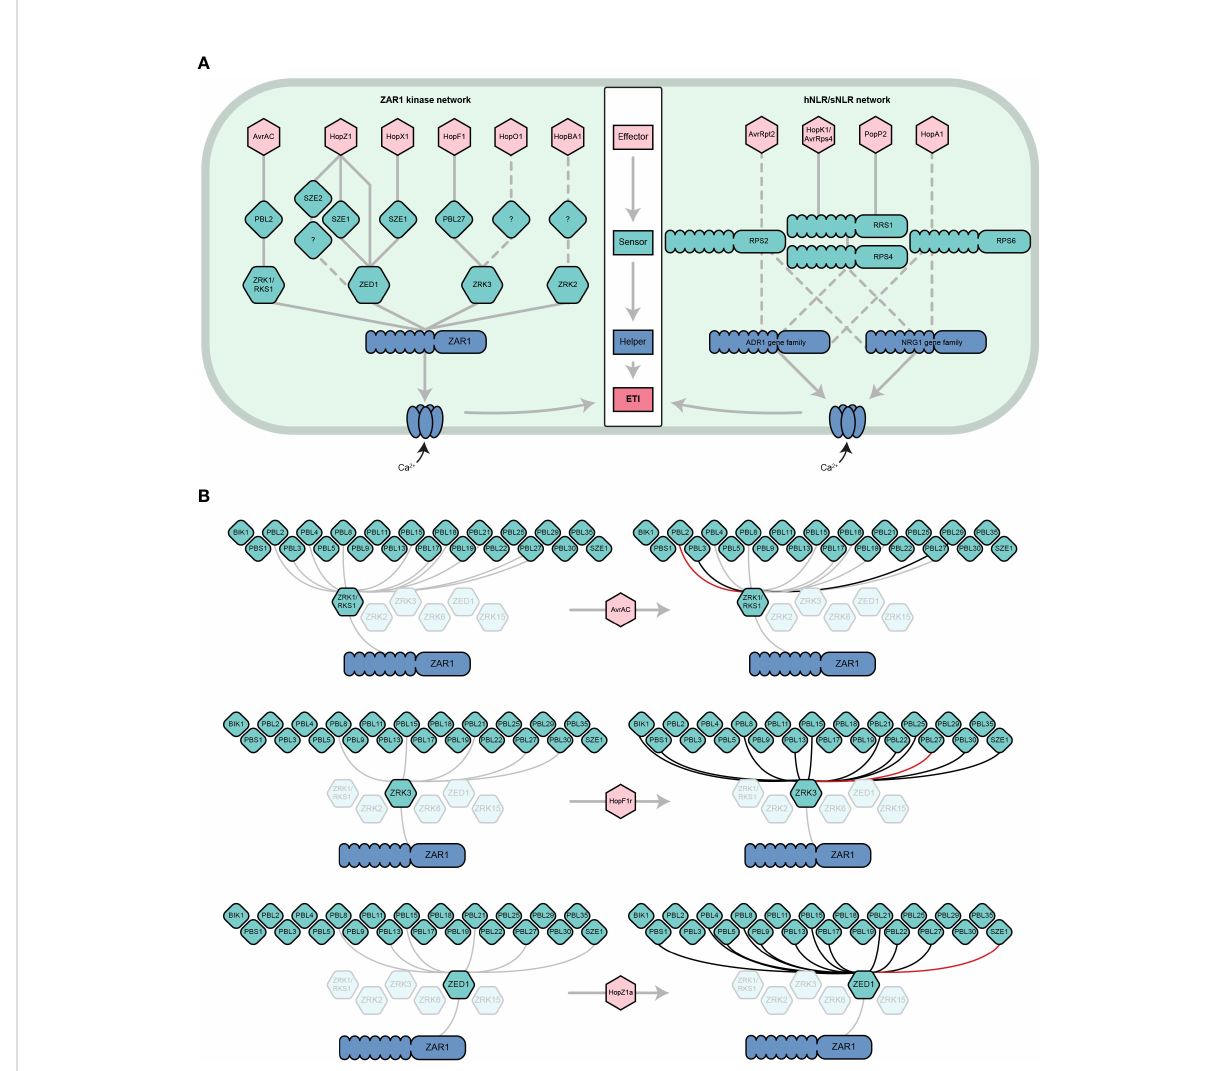
FIGURE 1 The dynamic ZAR1/kinase immune signaling network. (A) Parallels between the ZAR1/kinase (left) and hNLR/sNLR (right) immune signaling networks. ZAR1 and hNLRs play similar roles in A. thaliana ETI. Six effector families are indirectly recognized by ZAR1 through its interactions with ZRK (green hexagons) and PBL (diamonds) kinase sensors (Wang et al., 2015; Seto et al., 2017; Liu et al., 2019; Martel et al., 2020; Seto et al., 2021). Analogously, several distinct effector families are recognized by sNLRs, which go on to activate NRG1 and/or ADR1 hNLRs (only a subset are represented) (Bonardi et al., 2011; Dong et al., 2016; Castel et al., 2019; Wu et al., 2019). Like the ZAR1 resistosome, hNLRs oligomerize and localize to the cell membrane to form calcium-permeable channels. Solid lines represent physical interactions whereas dashed lines represent signaling dependencies, which may include physical interactions that have yet to be demonstrated. Other ETI components of the sNLR/hNLR network (e.g., EDS1, NDR1) have been omitted for simplicity. This panel is adapted from Martel et al., 2020 and Jubic et al., 2019. (B) ZRK-PBL interactions induced by the effectors AvrAC, HopF1r, and HopZ1a according to the results of Bastedo et al., 2019; Seto et al., 2021, and Martel et al., 2020. Grey lines represent physical interactions that occur in the absence of an effector, black lines represent physical interactions that are induced or strengthened by the presence of an effector, and red lines represent the ZRK-PBL interaction required for the ETI response to the given effector in A. thaliana . Shown are the ZRKs that have been demonstrated to interact with ZAR1 (Wang et al., 2015) and the PBLs that have been demonstrated to interact with ZRKs (Bastedo et al., 2019; Seto et al., 2021). For more information about effector nomenclature, refer to (Lindeberg et al.,